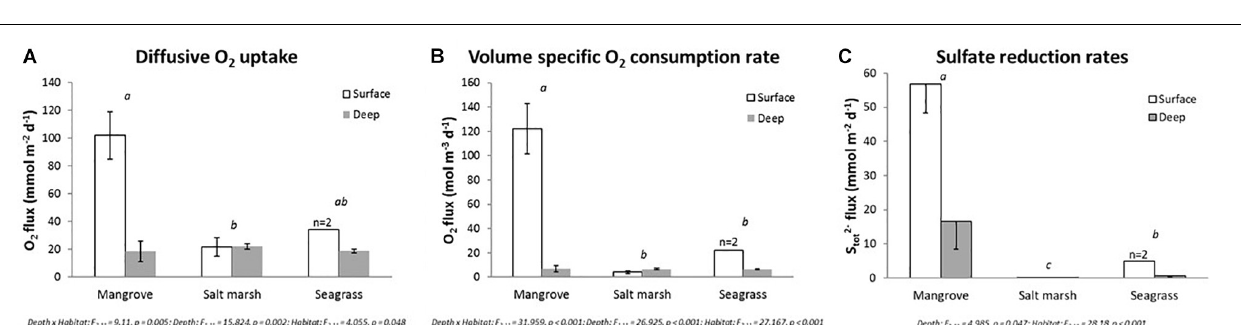
FIGURE 3 | pH microprofiles in surface [“surface”; 0–10 cm; panel (A) ] and deeper [“deep”; > 50 cm depth; panel (B) ] sediment layers of sediments originating from mangrove, salt marsh, and seagrass ecosystems (Sydney area, NSW, Australia). pH values were measured down to a maximum vertical depth of 2.5 cm. Legend depicts the investigated VCH. Symbols and lines represent mean values ± SEM; n = 6–9, technical replicates (biological replication of 2–3).